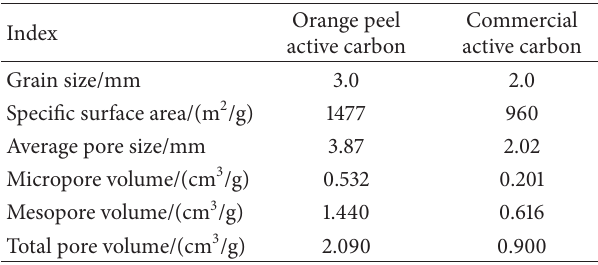
Table 2: The main performance parameters of activated carbon in experiment.